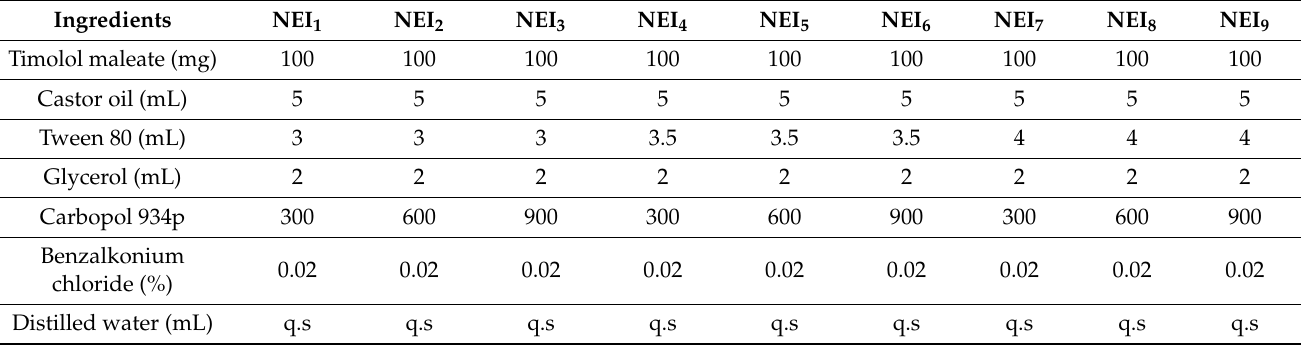
Table 1. Compositions of the trial